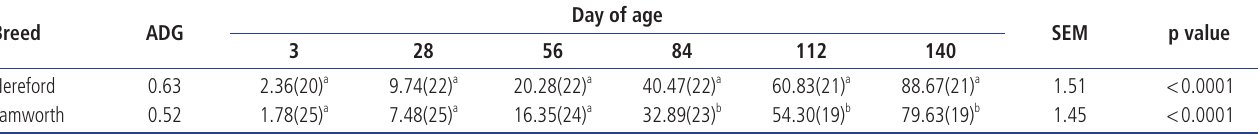
Table 5. Least square means and number of observations of body weights of Berkshire pigs sired by Hereford and Tamworth 1)